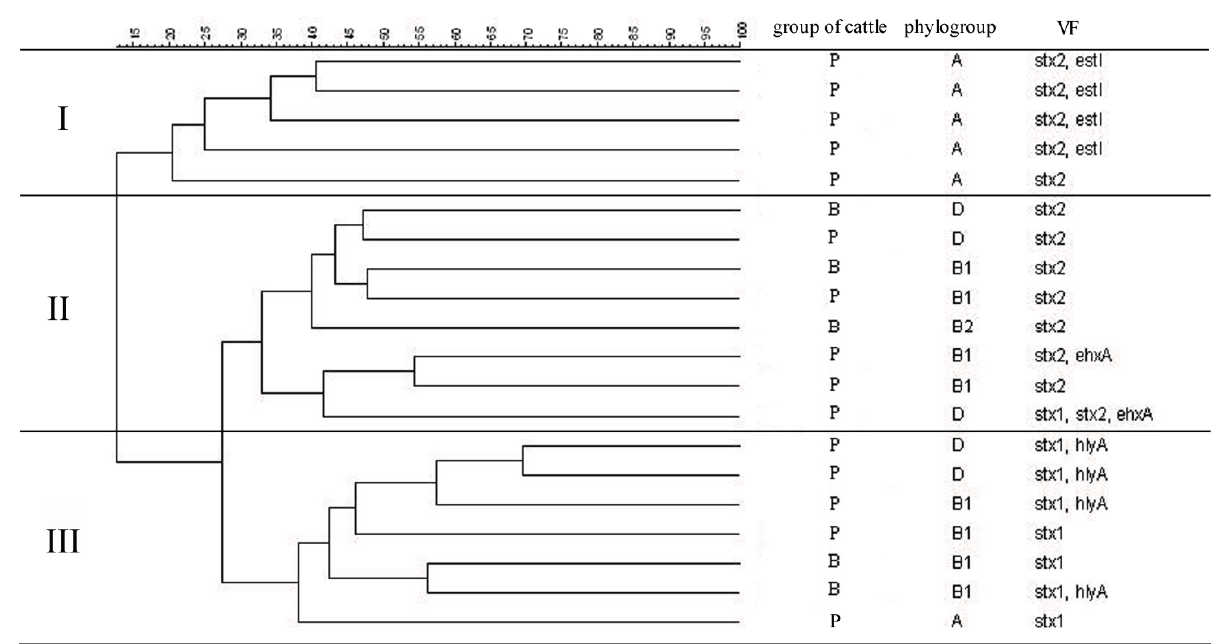
Figure 2. Dendrogram shows the similarity relationships between clustered STEC isolates based on BOX-PCR genomic patterns, phylogenetic grouping and virulence genes content using UPGMA grouping method. B-barn,